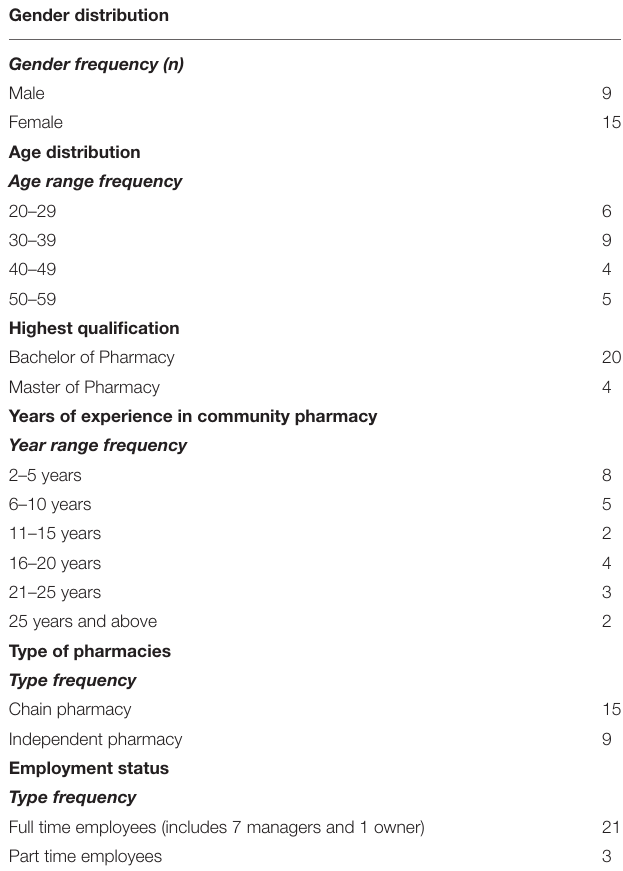
TABLE 1 | Sociodemographic and practice characteristics of participants ( n =